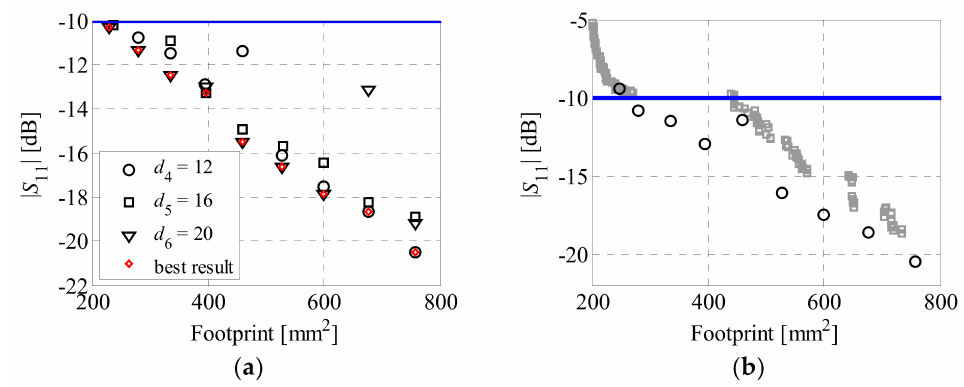
Figure 12. Comparison of the optimized antenna designs obtained using ( a ) different numbers of adjustable parameters, as well as ( b ) conventional MOEA and the presented nested algorithm ( d 4 =